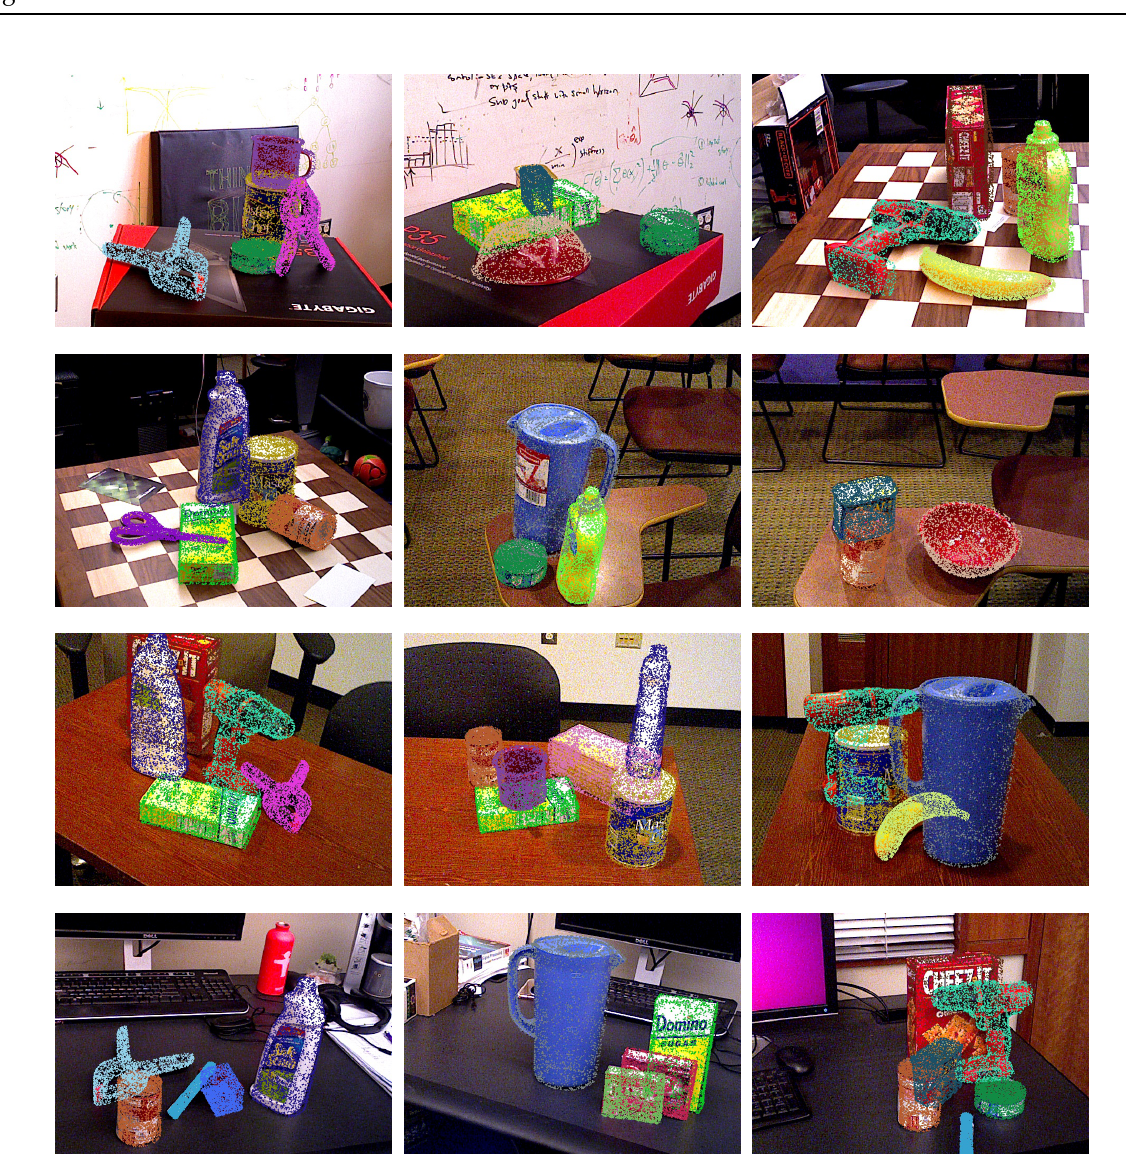
Figure 5. Some visualization results of the YCB dataset. The proposed method performs well even when the objects are seriously